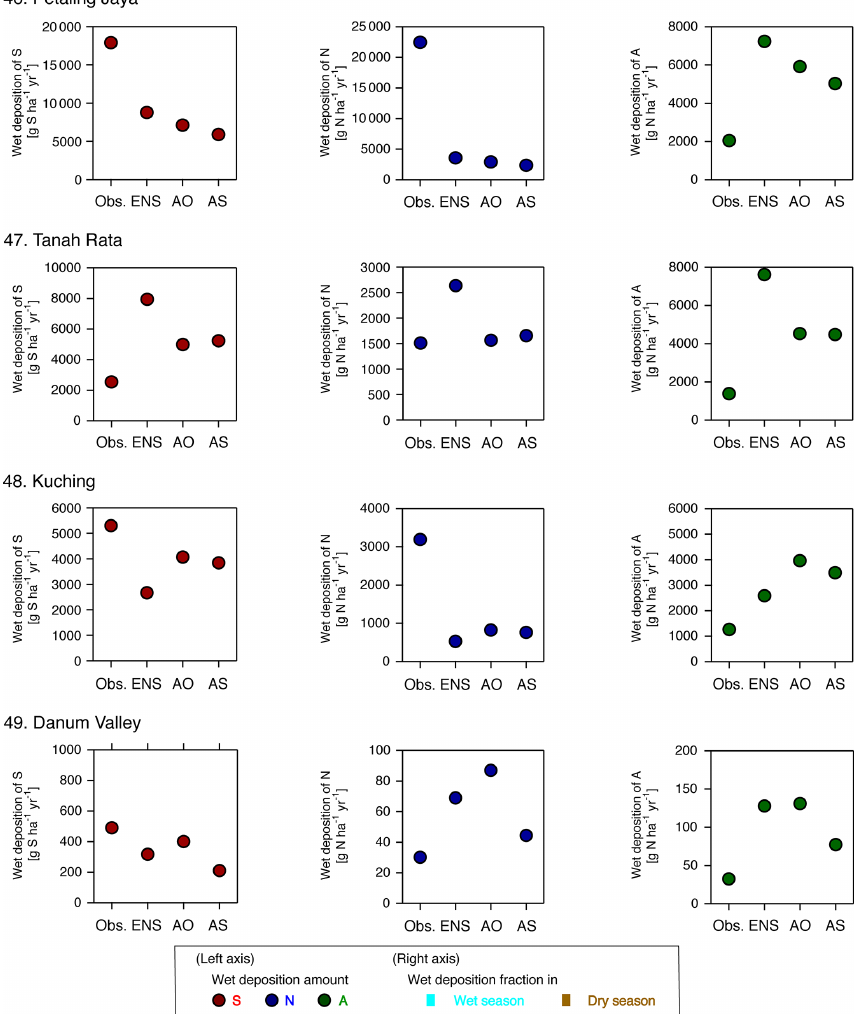
Figure 15. Observed and simulated annual accumulated wet deposition amounts of S, N, and A at four sites in Malaysia. The annual accumulated wet deposition amount is based on the months for which wet deposition observations were available (see Fig.